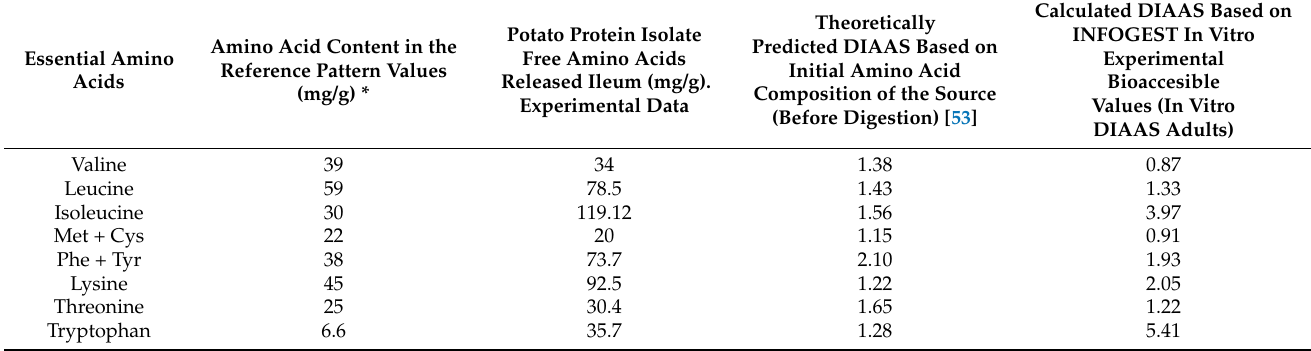
Table 3. Digestible indispensable amino acid score (DIAAS) calculations for potato protein based on initial amino acid composition of the potato protein sample [53] and DIAAS based on the in vitro digestibility by measuring presence of essential individual essential amino acids per g of protein (mg/g) in the bioaccessible fraction available at the ileum of the last intestinal point (I5). Free amino acids were measured by LC-TQ-MS. * Values of the reference pattern correspond to the adult maintenance amino acid pattern (mg/g) as recommended in the dietary protein quality evaluation in human nutrition report (FAO,